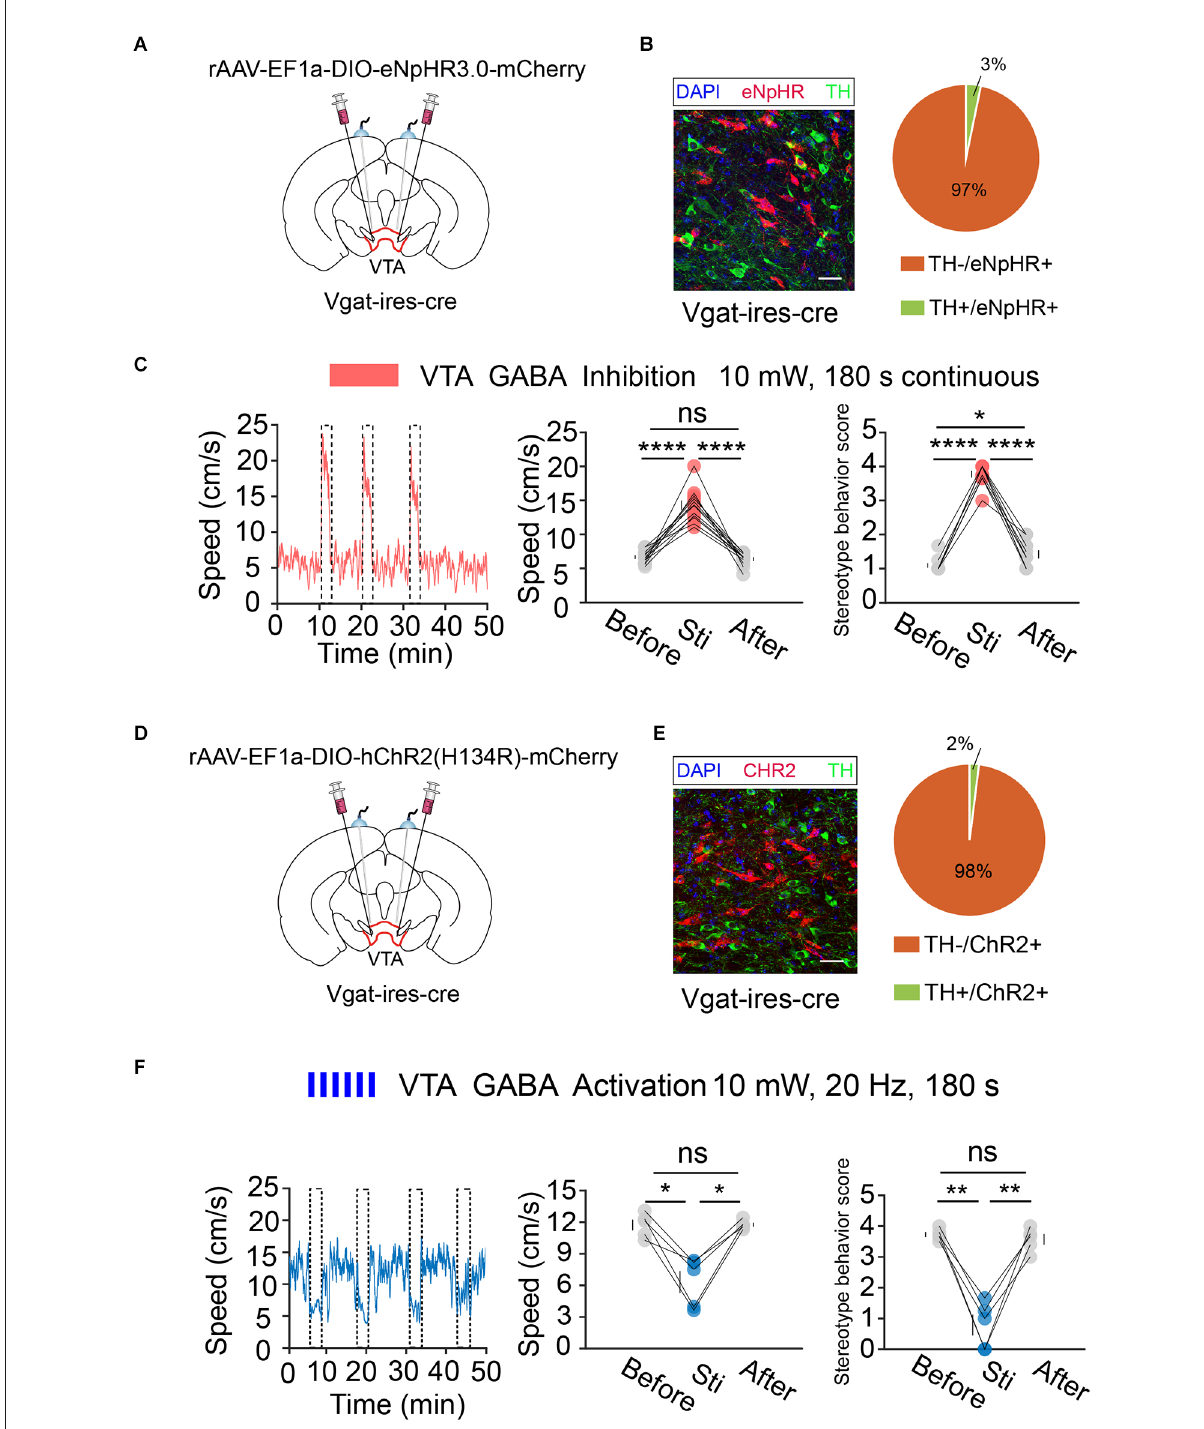
FIGURE6 Optogenetic manipulation of VTA GABA neurons. (A) Schematic of viral injection and fiber implantation above the VTA in Vgat-ires- cre mice. (B) Successful expression of eNpHR3.0-mCherry in VTA GABA neurons and optical fiber implantation above the VTA. The image shows eNpHR + cell bodies (red) and TH+ neurons (green) in Vgat-ires-cre mice. Scale bar, 20 µ m. TH, tyrosine hydroxylase. Right: quantification (the pie chart) of expression of TH in eNpHR-positive neurons in the VTA of Vgat-ires-cre mice ( n = 3 sections per animal from five animals). (C) Left: the movement speed in response to 180 s photoinhibition of VTA GABA neurons in Vgat-ires- cre mice; middle: quantification of movement speed before, during, and after VTA GABA photoinhibition. **** p < 0.0001,